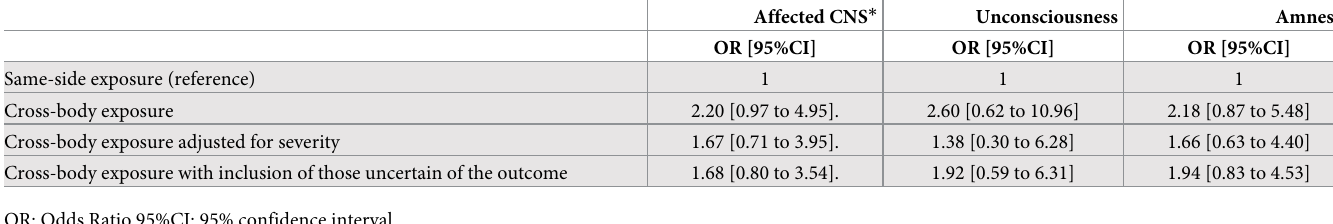
Table 2. Sensitivity analysis of the association between cross-body exposure and affected CNS in terms of unconsciousness and/or